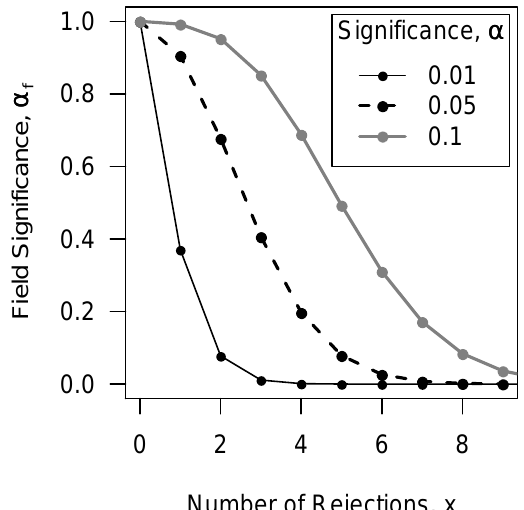
Fig. 3. Plot of the field significance level α f associated with n = 46 hypothesis tests, each with an individual significance levels of α = 0 . 01, 0.05 and 0.10 based on Eq. (10).